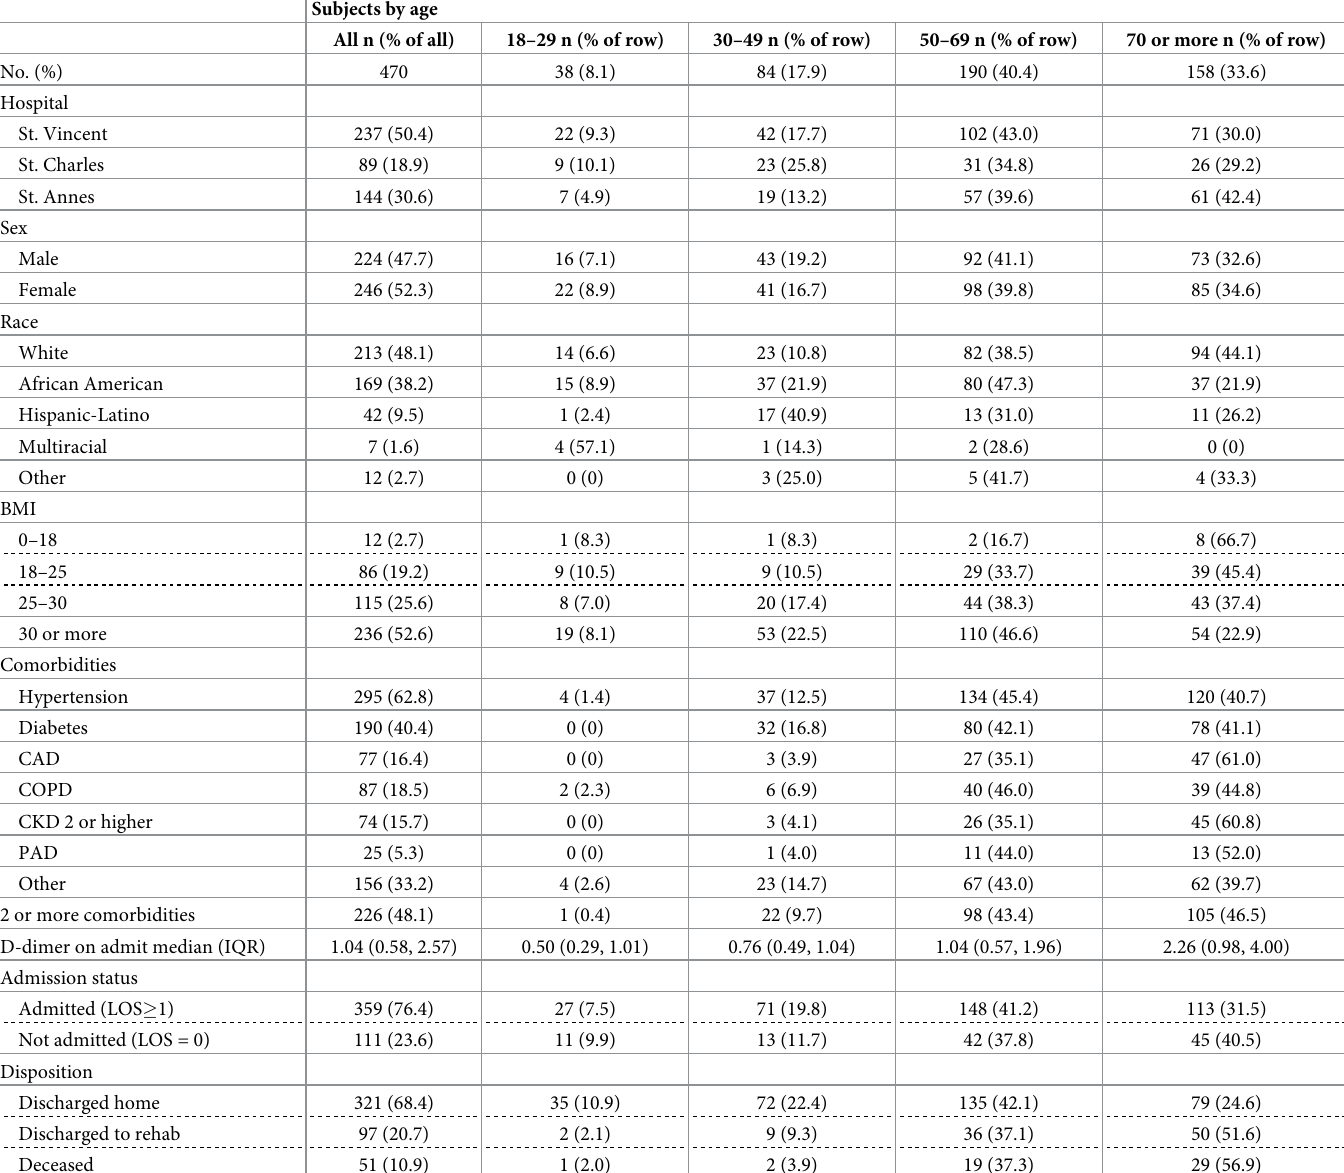
Table 1. Demographic and clinical characteristics of COVID subjects, total and by age